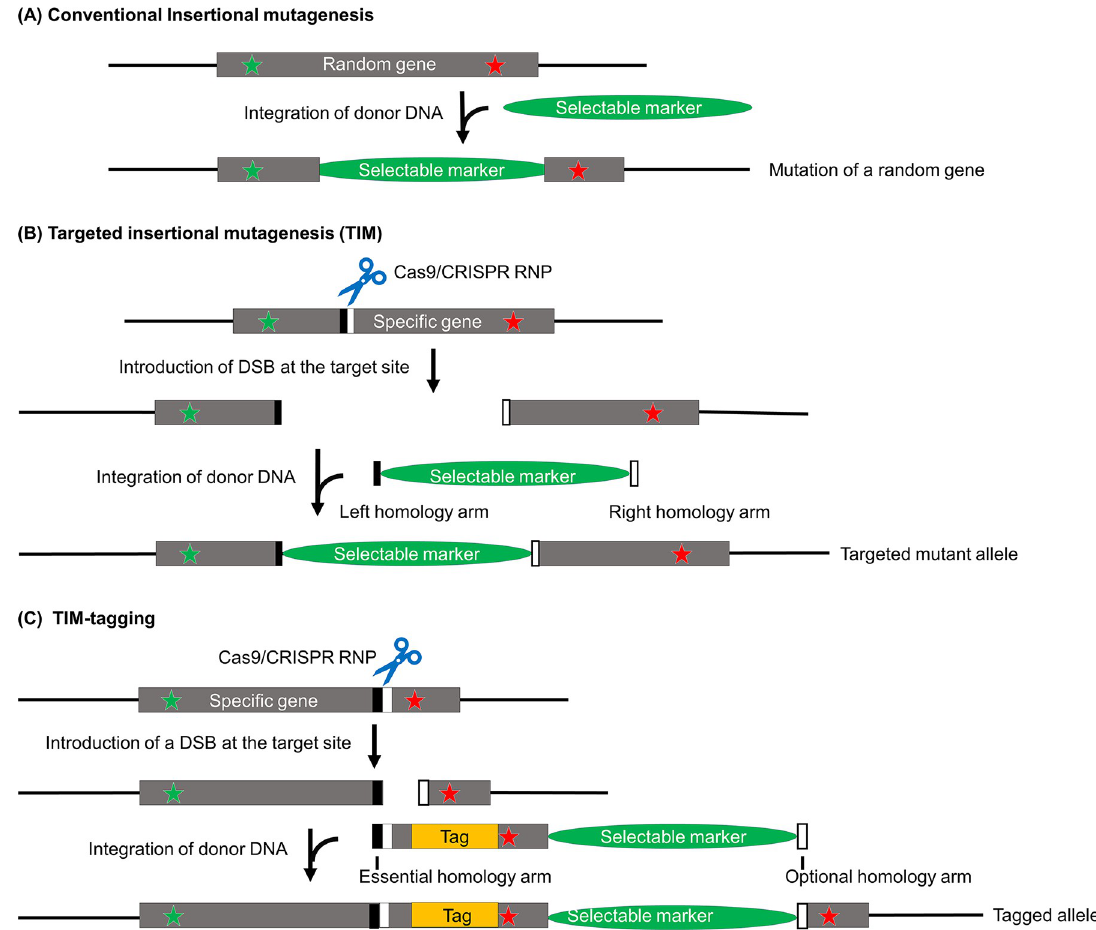
Fig 1. Schematic overview of conventional insertional mutagenesis, TIM, and TIM-tagging in C . reinhardtii . (A) Conventional insertional mutagenesis to create mutants randomly. Donor DNA encoding a selectable marker is introduced into the cell; it then inserts randomly into the nuclear genome, causing a large insertion, deletion, and/or reorganization at the site of integration. (B) Targeted insertional mutagenesis (TIM) to disrupt a specific gene of interest. Based on insertional mutagenesis, but a CRISPR/Cas9 RNP is included in the transformation step and short gene-specific homology arms are added on both ends of the donor DNA. The RNP creates a DSB at the target site, which facilitates the incorporation of donor DNA at this site. The homology arms further increase the probability that the donor DNA will insert at this site, but they are not critical for success. Transformants expressing the selectable marker are screened by gene-specific PCR analysis to identify those in which the target gene has been disrupted. (C) TIM-tagging to specifically tag a gene of interest, as illustrated here for C-terminal tagging. Based on TIM, but the RNP target site is placed close to and upstream of the intended tagging site. The donor DNA starts with an essential homology arm to promote precise integration via homology-directed repair (HDR) at this end of the donor DNA, and then continues with the rest of the gene, including the tag sequence, followed by a selectable marker. A second homology arm at the 3’ end of the donor DNA is optional but might be helpful. In the final result, the allele contains the tag sequence, and is followed by the selectable marker. Following selection of transformants, cells that have integrated the tag sequence are identified by gene-specific PCR analysis. Green star: start codon; red star: stop codon; black and white boxes: homology arms on donor DNA or sequence on gene matching homology